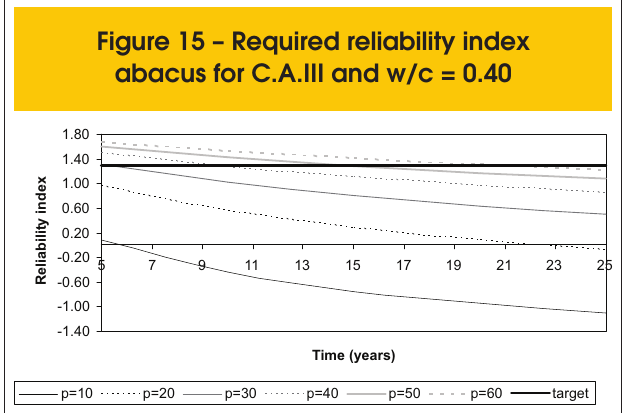
Figure 15 – Required reliability index abacus for C.A.III and w/c = 0.40